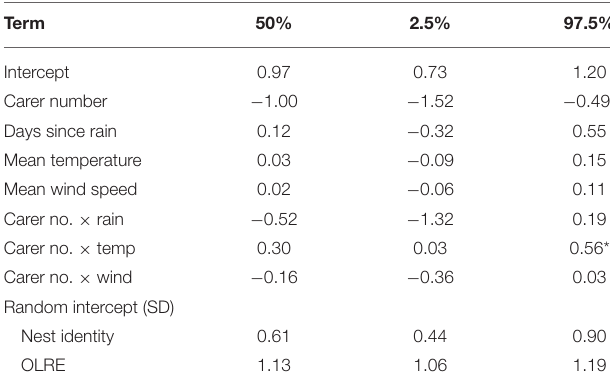
Table shows parameter estimates as posterior median and 95% CI from a GLMM of the number of visitation events separated by ≥ 1 min divided by the total number of visits. A negative value reflects increased group-level synchronization. Carer number (or no.) refers to the number of carers minus the breeding female in the group. Days since rain (or rain) refers to the mean days since last meaningful rainfall on days of observation during each nesting attempt, temperature (or temp) is the mean daytime temperatures on each day, and wind speed (or wind) refers to the mean daytime wind speeds. The standard deviation (SD) is shown for random intercepts: nest identity and OLRE. Significant effects are determined when CI’s fail to cross zero and are denoted * .